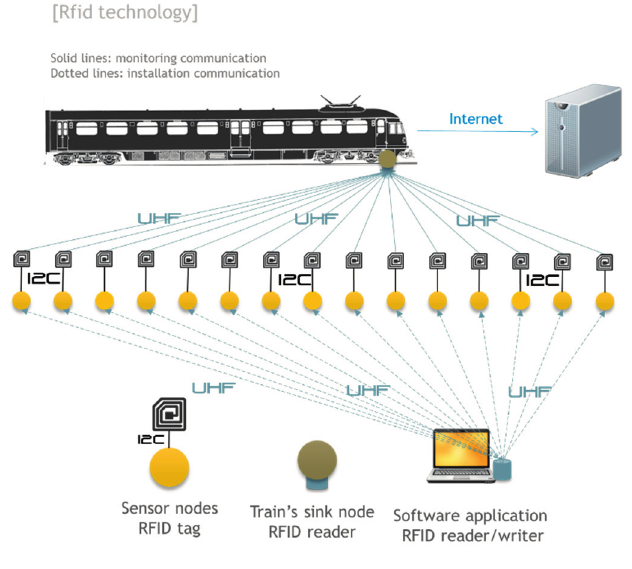
Figure 10. RFID: communication